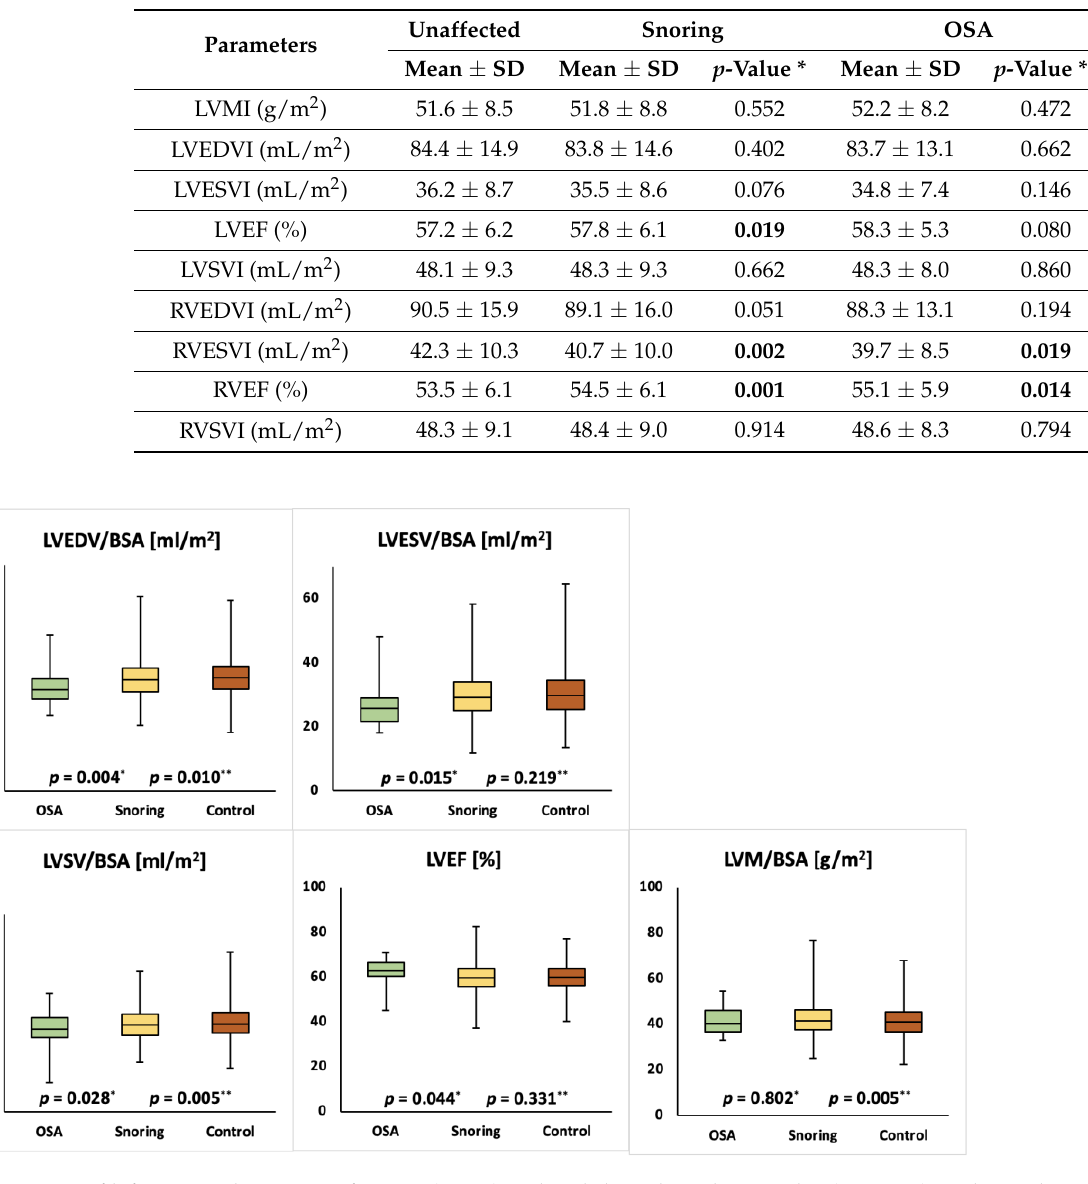
Figure 3. Comparison of right ventricular ejection fraction (RVEF) and end-diastolic volume index (RVEDVI), end-systolic volume index (RVESVI) and stroke volume index (RVSVI) in female